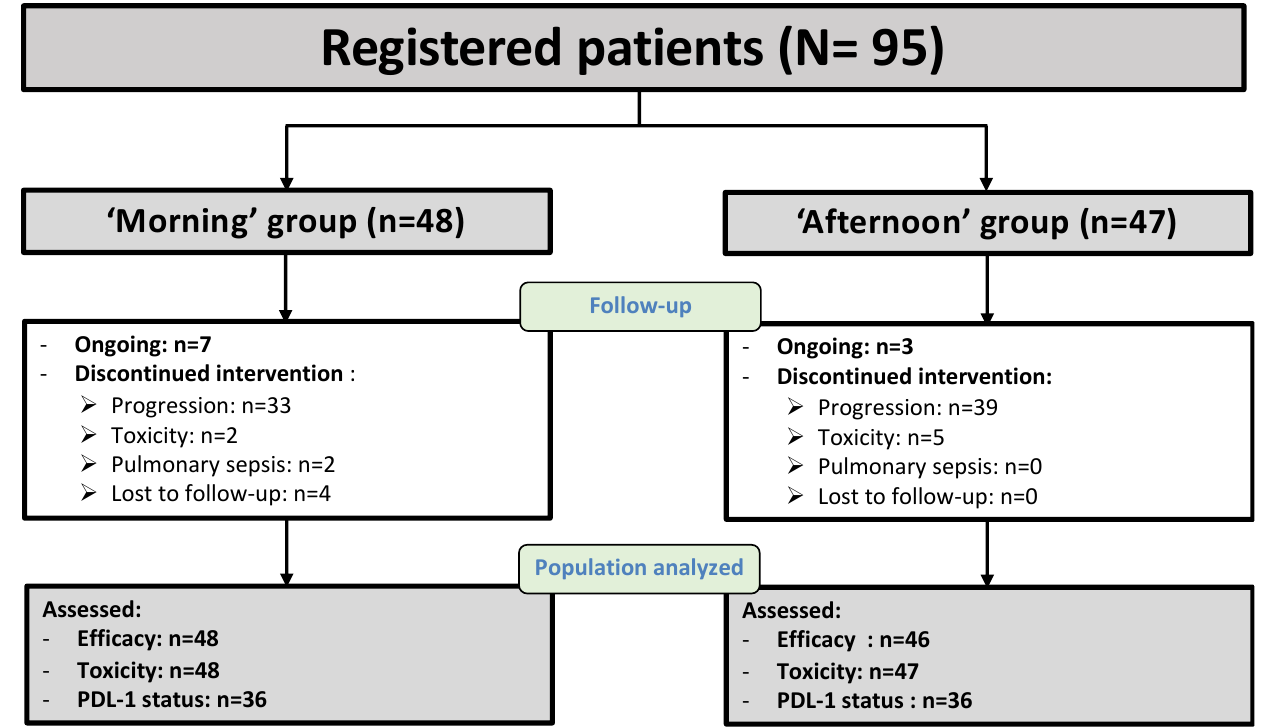
Figure 1. Study flow diagram.